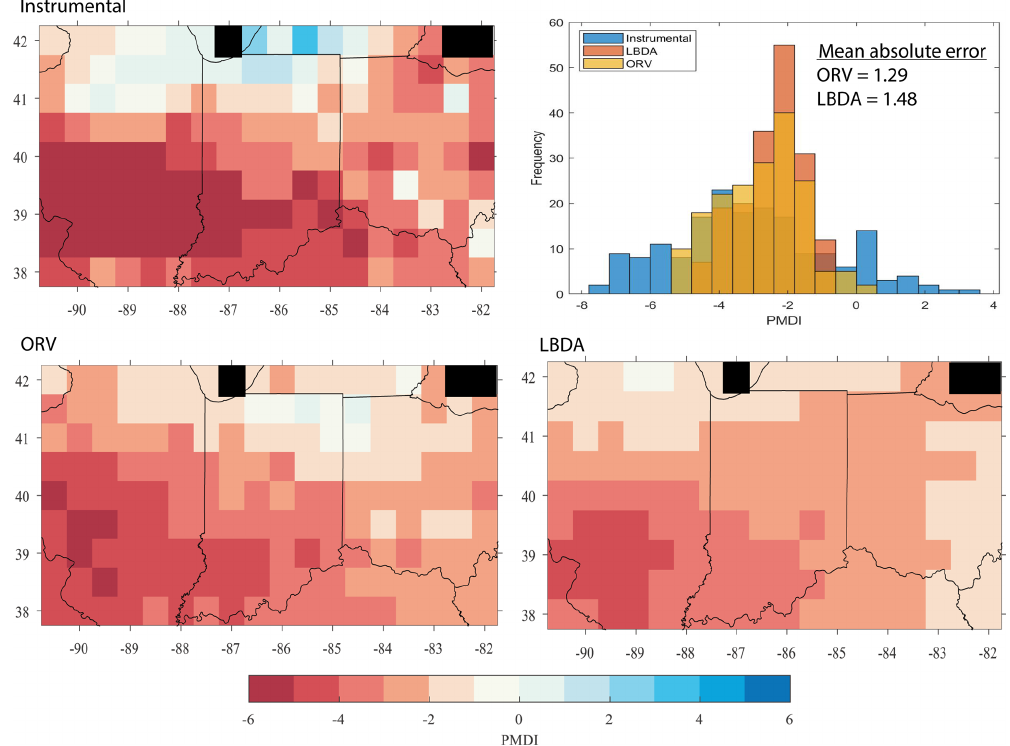
Figure 4. Maps showing PMDI values for the instrumental data, ORV, and LBDA reconstructions for the year 1954. The histogram represents the frequency of PMDI values for the instrumental, ORV, and LBDA PMDI values. The mean absolute error values show that the ORV reconstruction more accurately matches the instrumental data compared to the LBDA reconstruction. Black grids represent areas over water and therefore, no data.